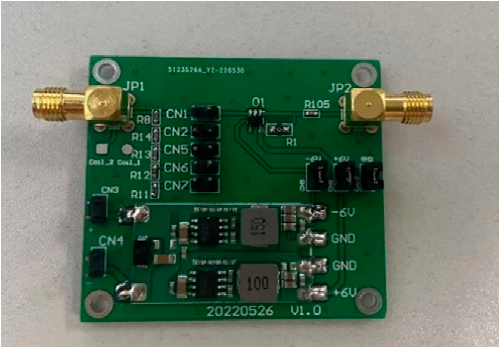
Figure 8. Multi-range PCB board with impedance matching function.